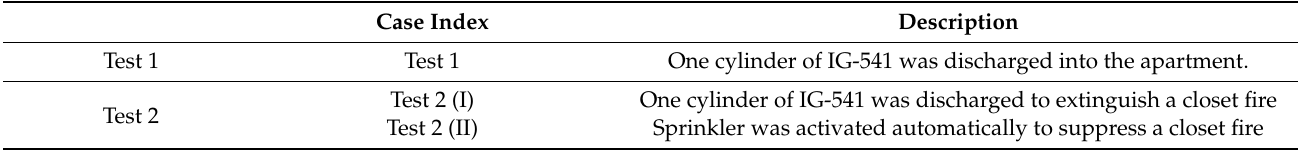
Figure 2. ( a ) The façade of the apartment; ( b ) fire load in the closet; ( c ) 115 s after ignition. Table 1. Summary of the